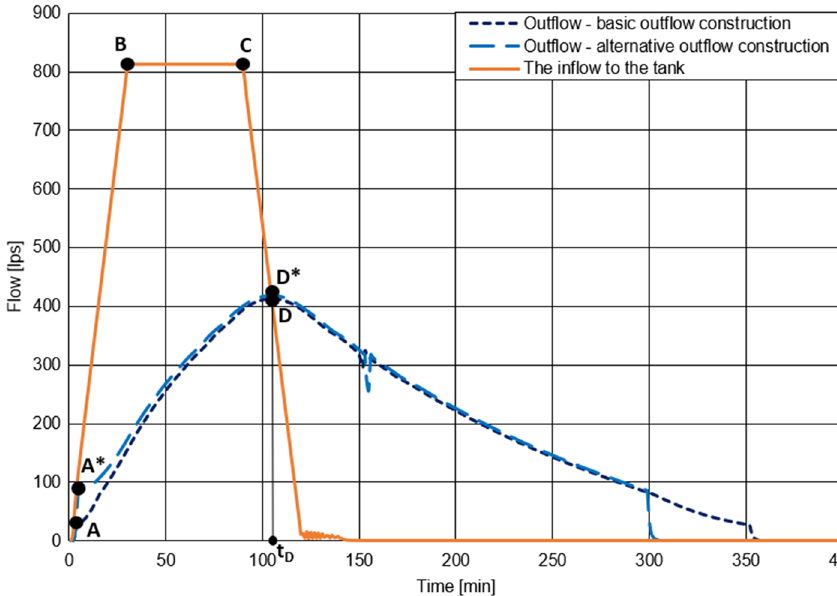
Fig. 2 An example of the inflow and two different outflow solu‑ tions as a function of